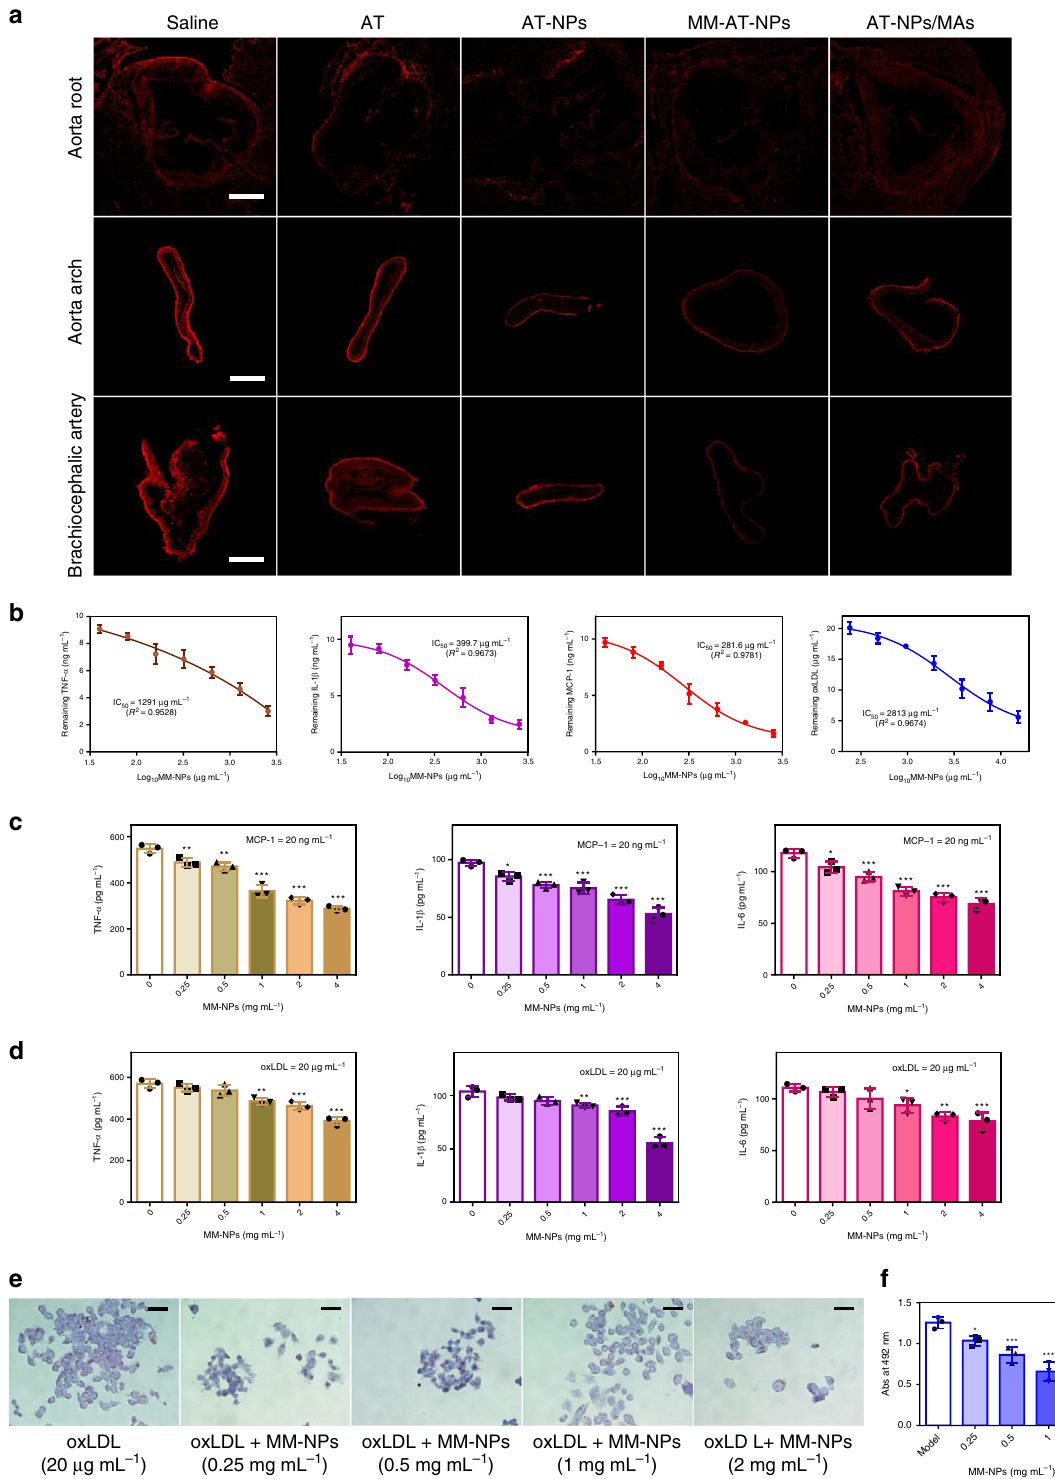
macrophage, macrophage membrane coated NPs ef fi ciently bind with, and sequester, multiple proin fl ammatory cytokines, and chemokines that play prominent roles in the atherosclerotic process, leading to in fl ammation neutralization. The combination of selective pharmacotherapy and sequestration of proin- fl ammatory cytokines/chemokines offered by this platform exhibited signi fi cant synergistic therapies against atherosclerosis in